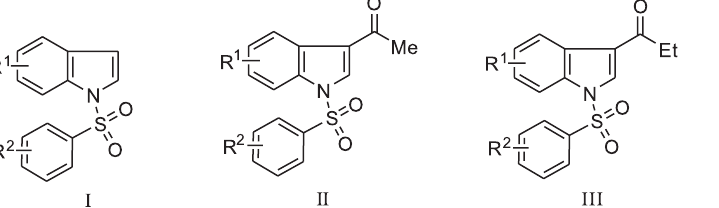
FIGURE 1 - Chemical structure of N -arylsulfonylindoles ( I ), N -arylsulfonyl-3-acetylindoles ( II ) and N -arylsulfonyl-3- propionylindoles ( III